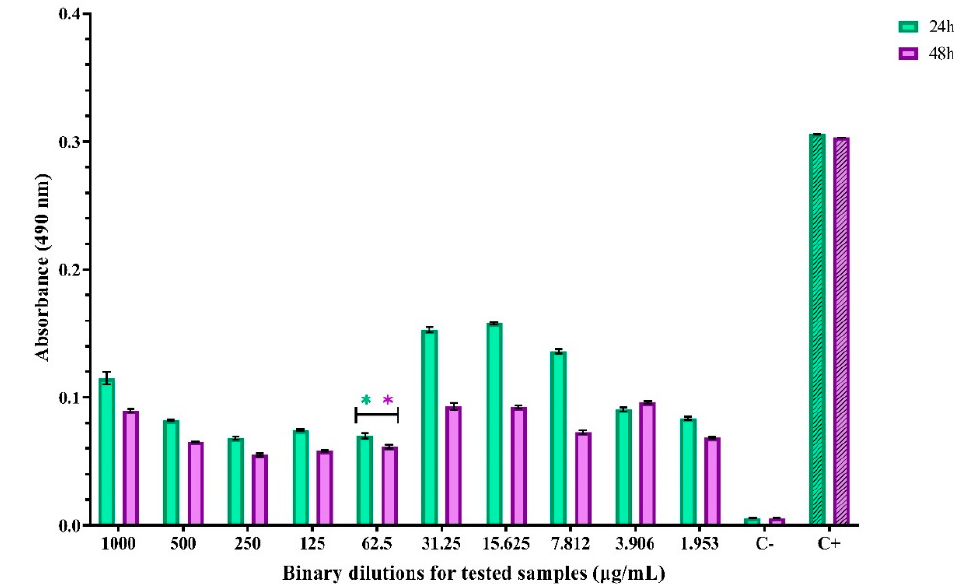
Figure 10. Absorbance values for evaluating anti-adhesion activity for ZnO nanoparticles against E. coli . * indicates the MBEC values and differences between groups are considered statistically significant ( p < 0.001).